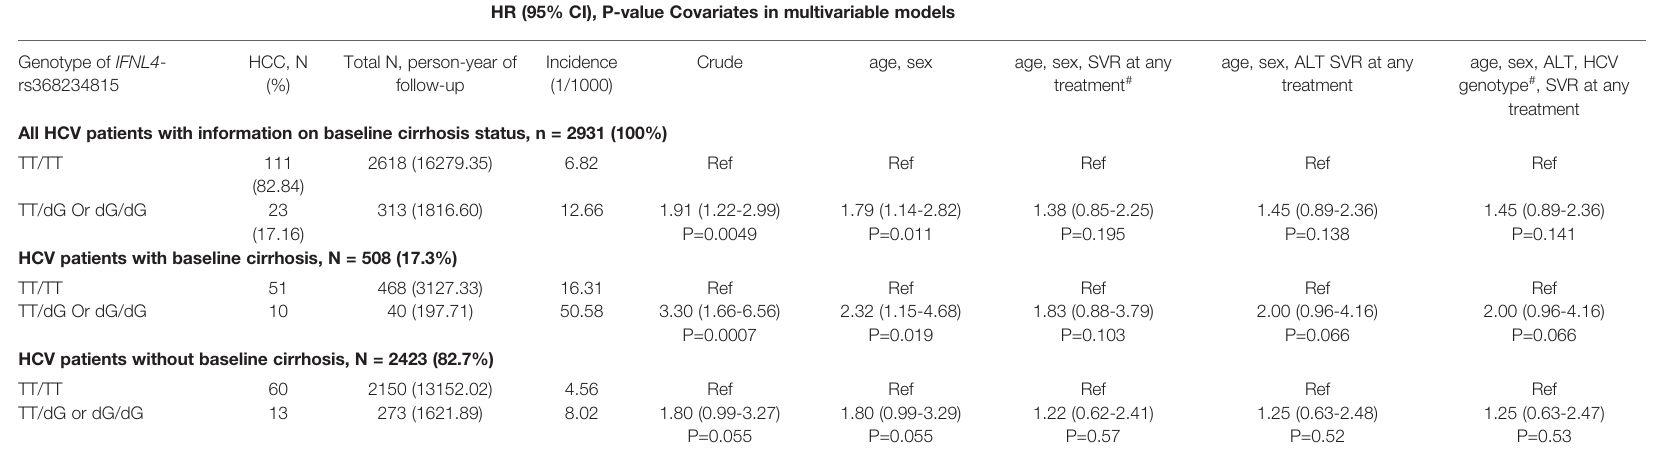
HR (95% CI), P-value Covariates in multivariable models